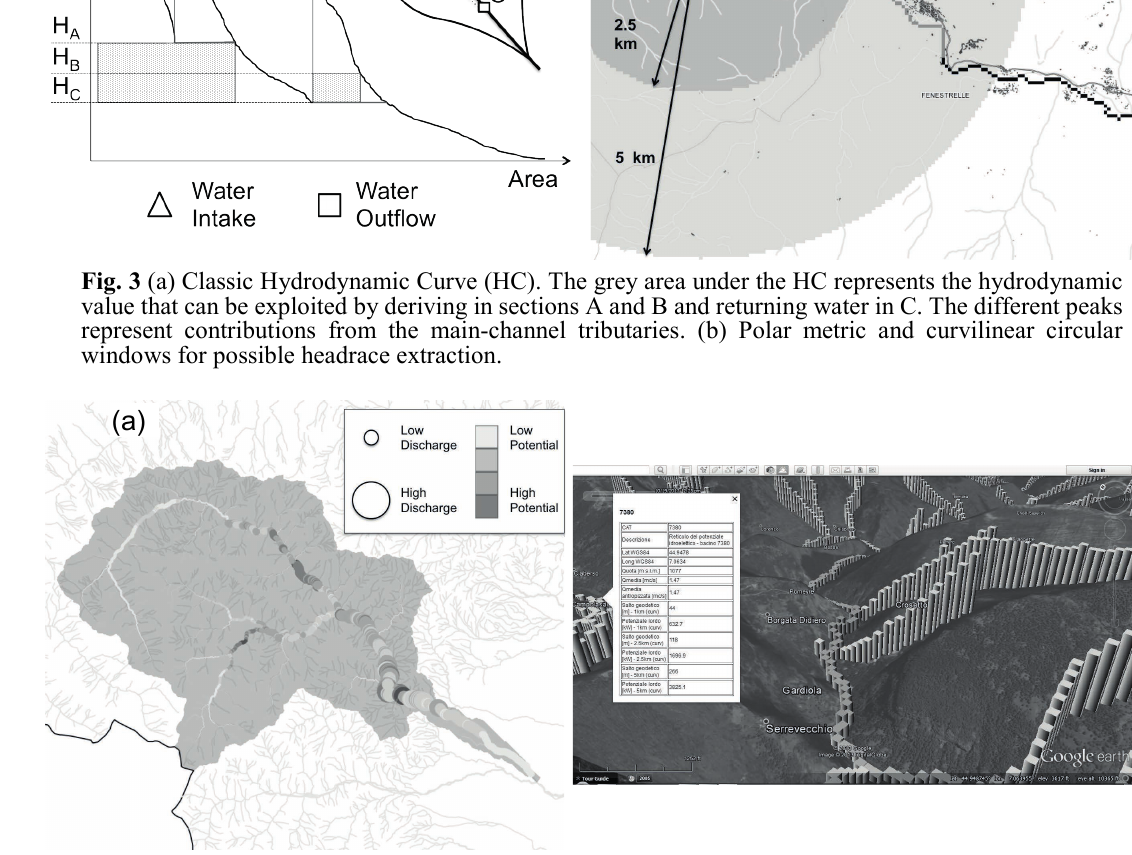
Fig. 4 Example of 2D (a) and 2.5D (b) representation of the Hydropower Potential